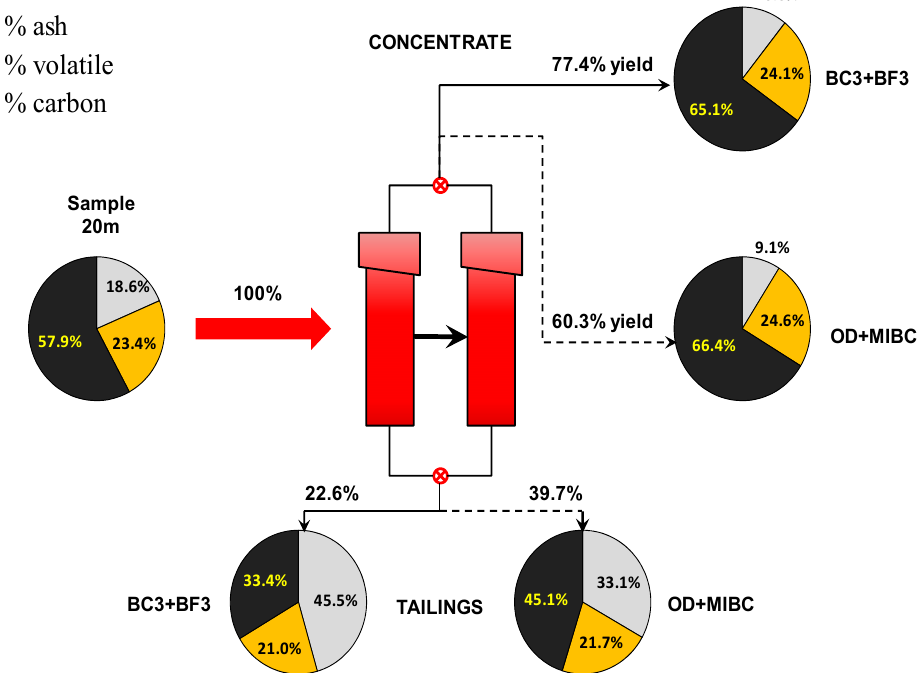
Figure 11. Mass balances of the best beneficiation scenarios for each reagent system (20 m distance).